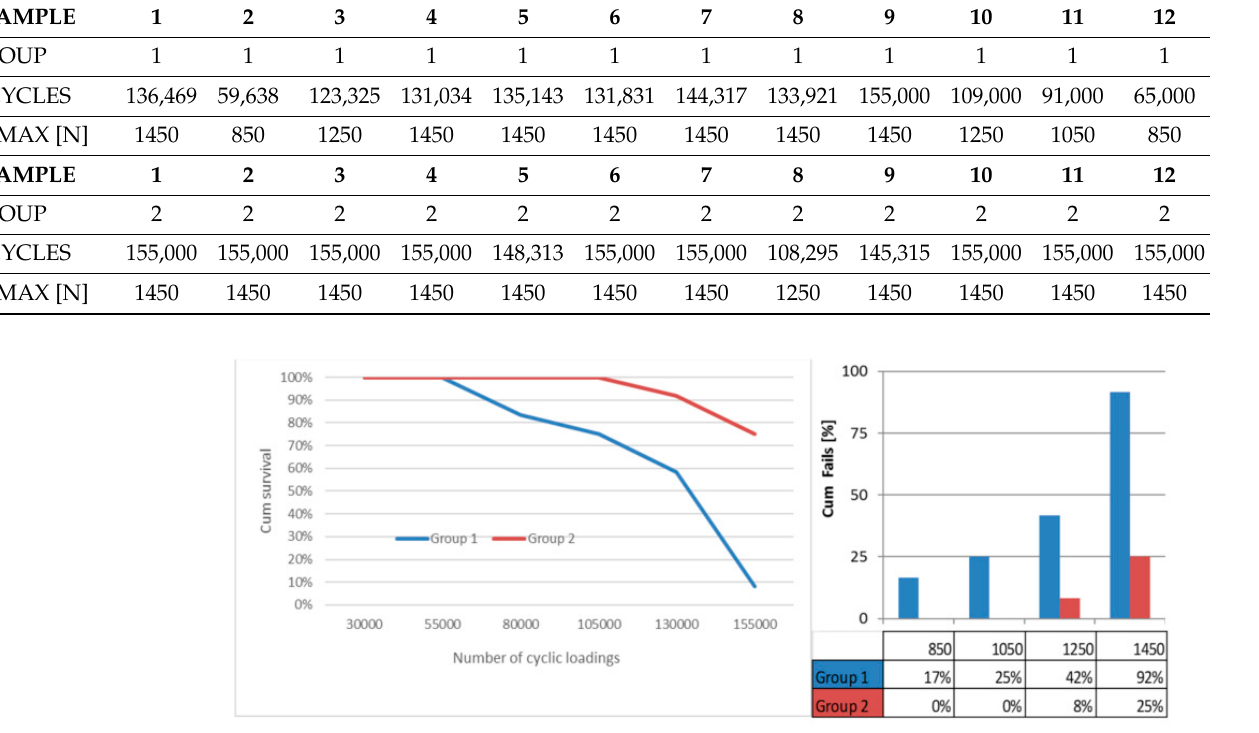
Figure 7. Fatigue test results. Cumulative failure as a function of the cycles and the load. Table 2. Fatigue test results (n = 12).